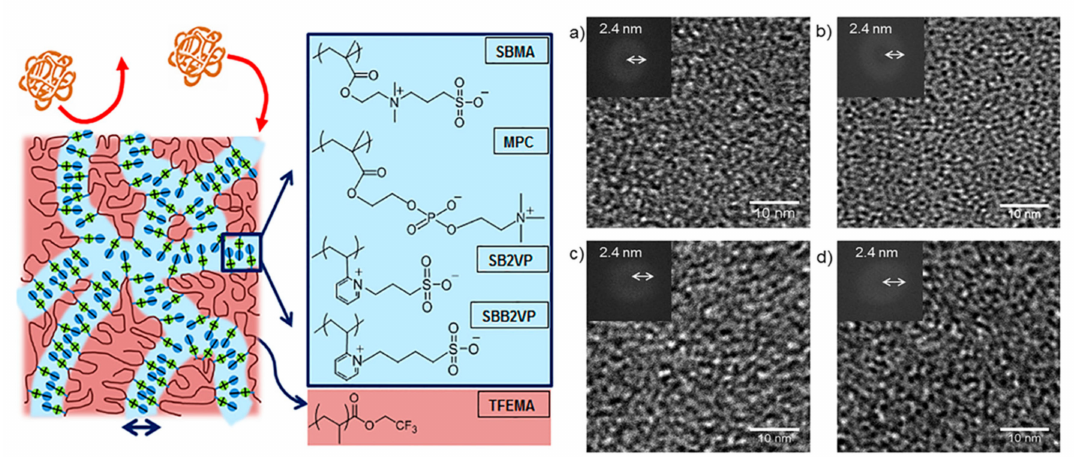
Figure 20. ( Left ) Schematic showing the self-assembly of zwitterionic amphiphilic random copolymers to form a network of water-permeable effective “nanochannels” and the interaction was formed between the selective layers of membranes with foulants (orange); ( Right ) TEM brightfield images of the self-assembled morphology of amphiphilic zwitterionic copolymers, exhibiting bicontinuous networks of zwitterionic (dark) and TFEMA (light) microphases. The insets show FFT of the images with the characteristic period shown on the arrow; ( a ) PT:SBMA, ( b ) PT:MPC, ( c ) PT:SB2VP, and ( d ) PT:SBB2VP exhibit similar characteristic periods of ~2.4 nm, yielding a zwitterionic channel size around 1.2 nm. Reproduced with permission from Reference